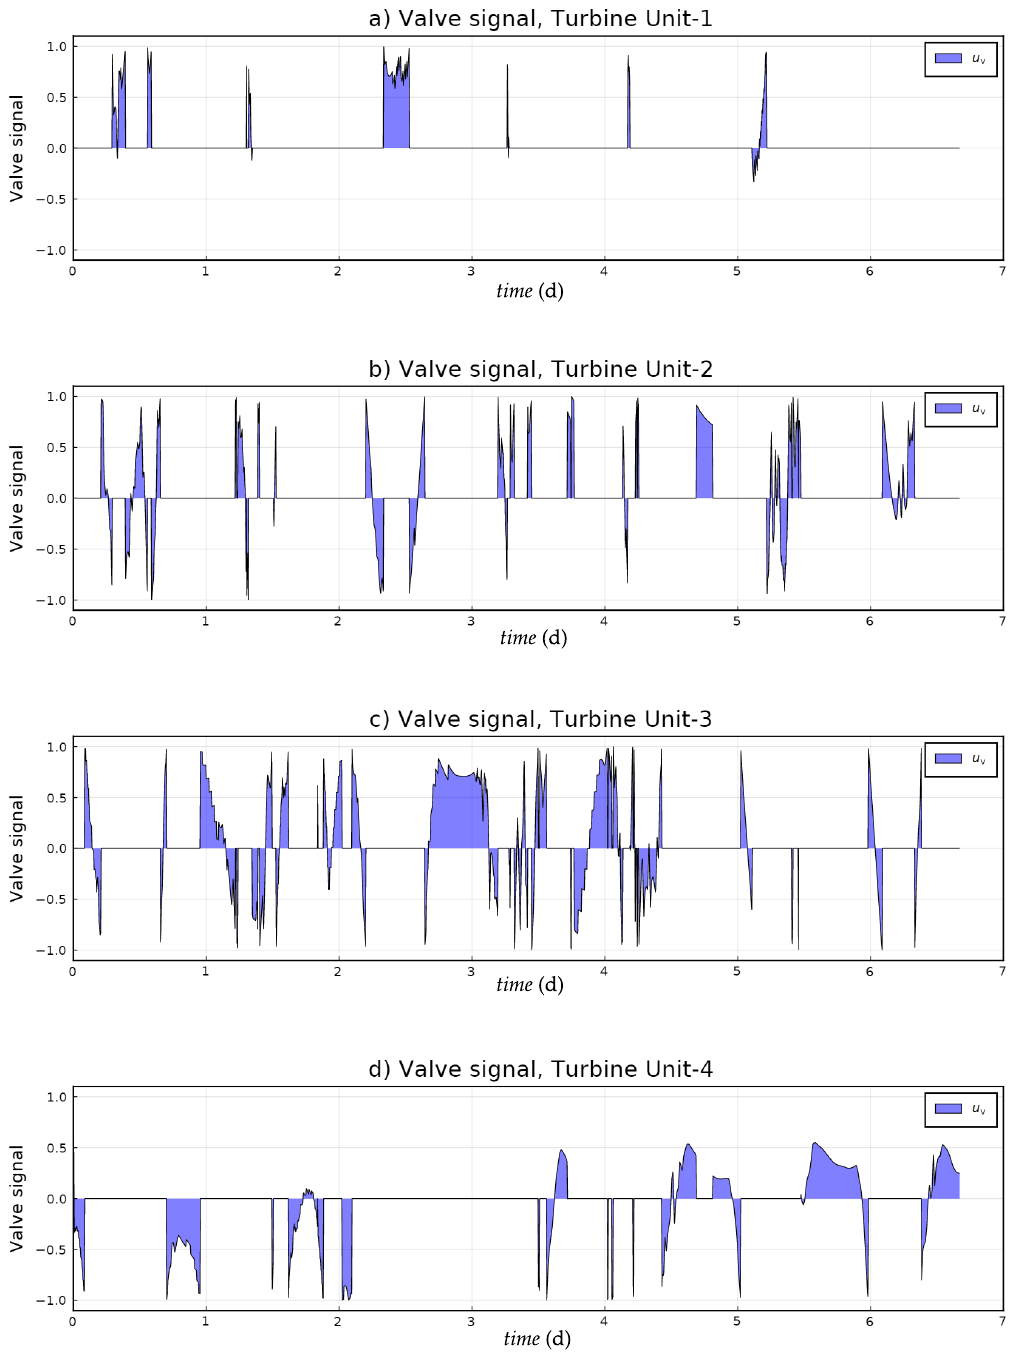
Figure 13. Pump-turbine operations of hydro power. u v ∈ ( 0,1 ) for each of the pump-turbines. Unit 1 gets first priority to run either in generating or motoring mode. If unit 1 operates in generating mode near full load, then after it reaches full load unit 2 starts to operate and balance the generation and load. And so on. The same applies to motoring